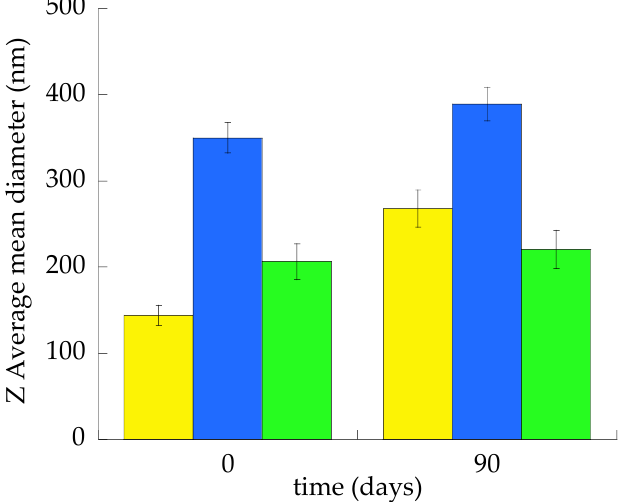
Figure 1. Mean diameters of ET (green), TET-1 (yellow) and TET-2 (blue), as measured by PCS at time 0 and after 3 months of storage at 22 °C. Data are the mean of three independent measure- ments ± s.d. ET vesicles were more stable, displaying an almost 20 nm increase in the mean diame- ter in 3 months, followed by TET-2, undergoing a 40 nm increase. The major size increment was achieved in the case of TET-1, passing from 144 to 268